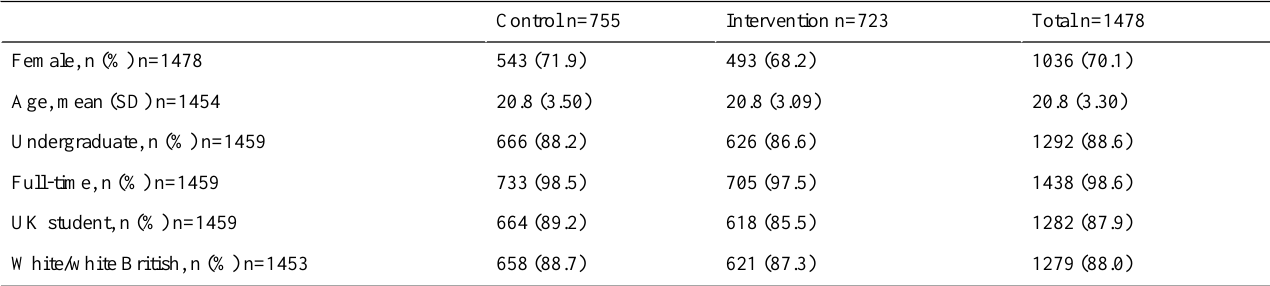
Table 1. Demographics of participants at baseline by treatment arm allocation (number of participants who provided demographic data is provided underneath demographic variable; percentages calculated as a percentage out of participants who provided variable